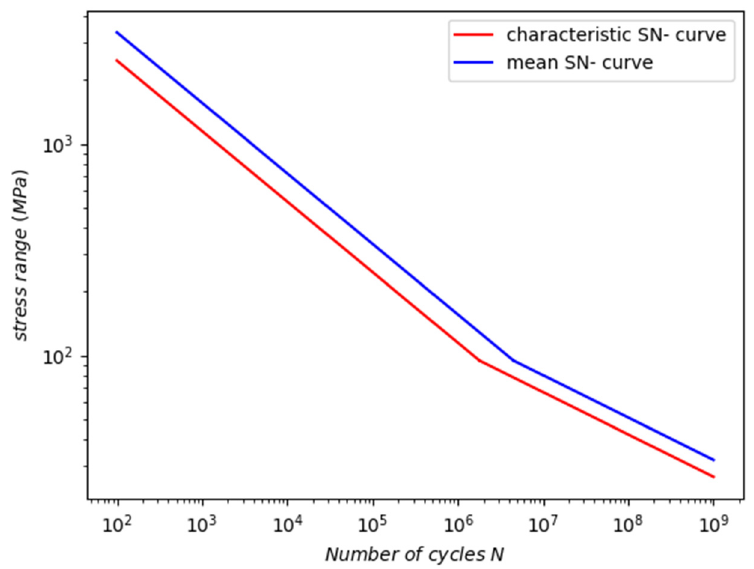
Figure 12. Bi-linear characteristic and mean SN curves for structures located in seawater environments with cathodic protections.